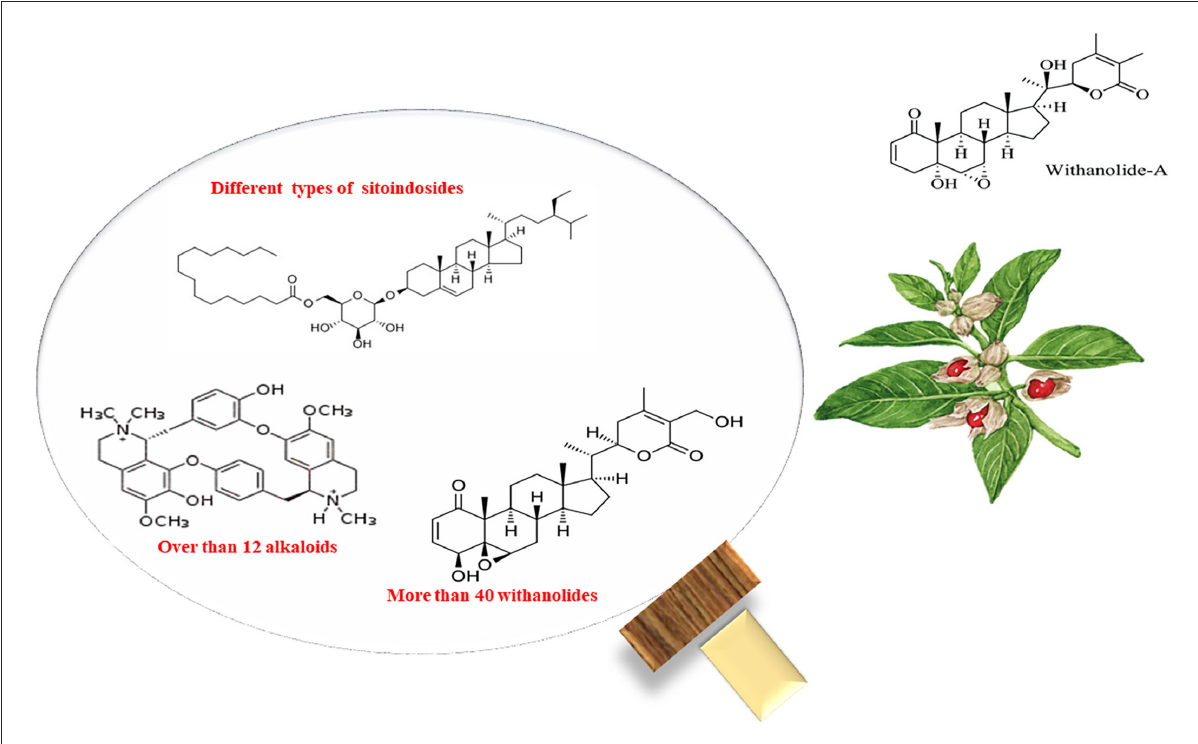
FIGURE1 Chemical composition of Withania somnifera